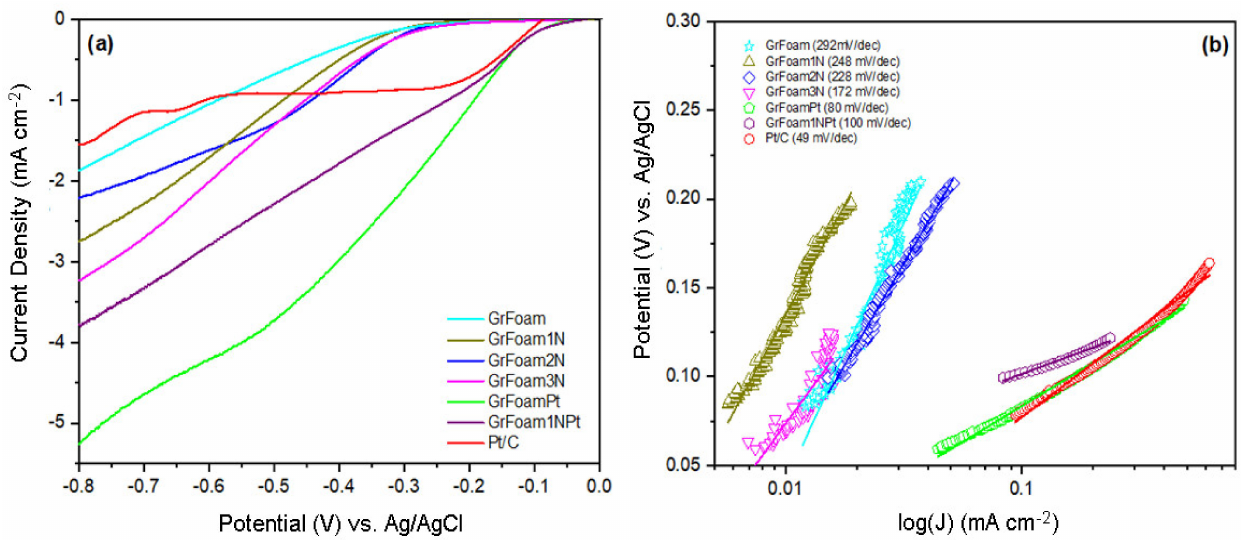
Figure 6. ( a ) Linear sweep voltammetry (LSV) plots recorded with a scan rate of 5 mV s − 1 in nitrogen saturated 0.1 M KOH; and ( b ) potential vs. logarithm of current density in absolute values and the calculated Tafel slopes are obtained from linear